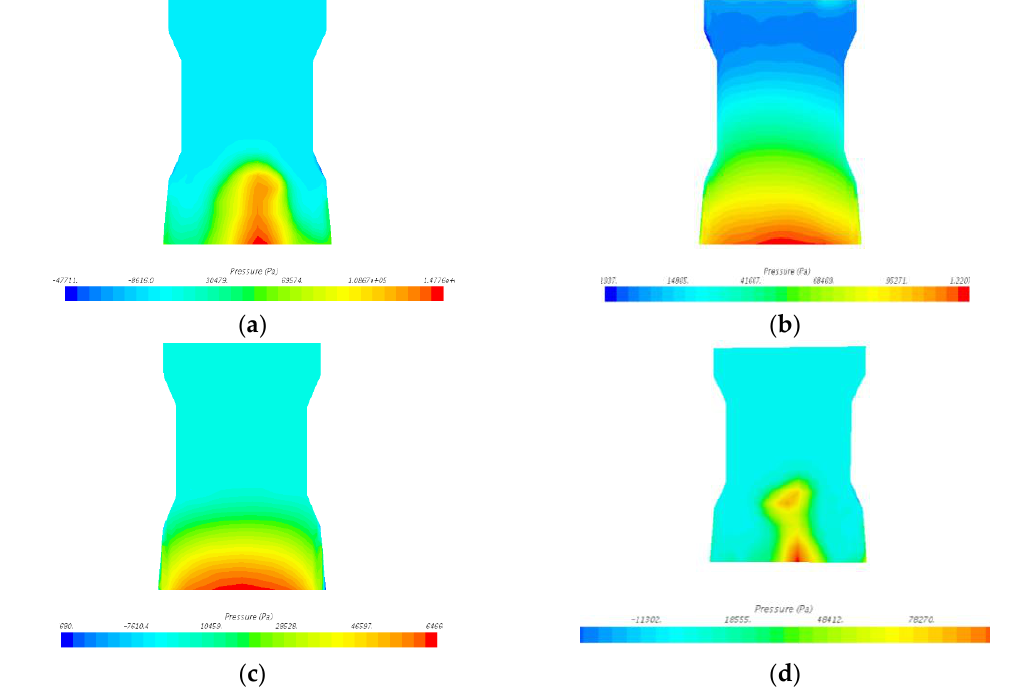
Figure 18. Slamming pressure distribution of column at different time. ( a ) t 1 = 175.795 s. ( b ) t 2 = 176.575 s. ( c ) t 3 = 180.615 s. ( d ) t 4 = 184.08 s.